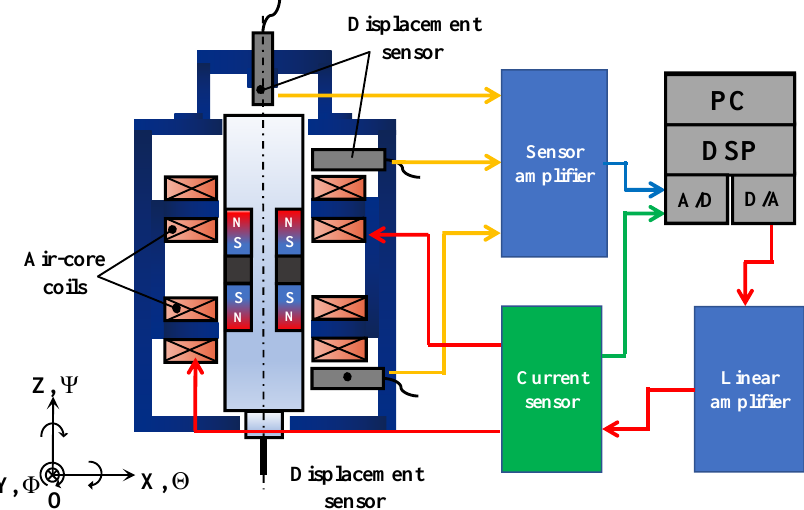
Figure 12. Structure of the experimental system.